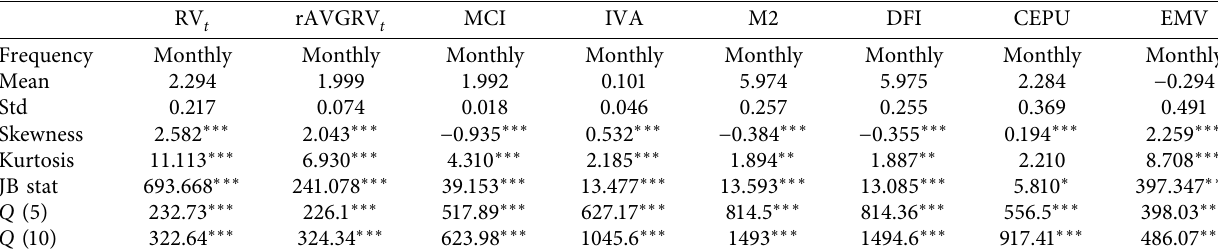
Table 1: Descriptive statistics.